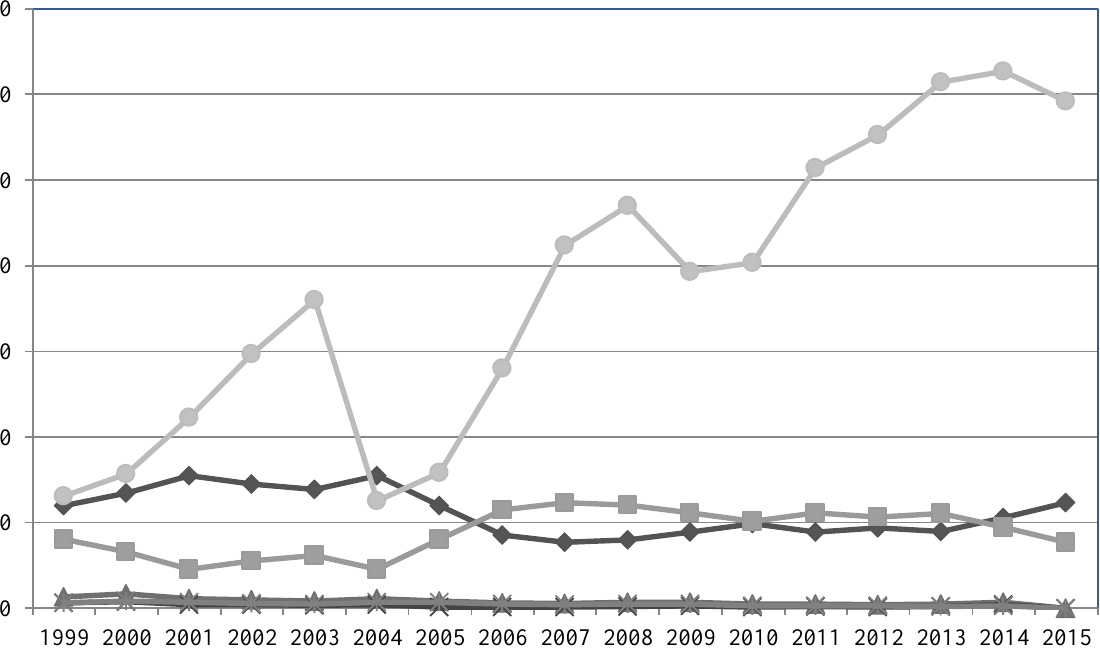
Fig. 2. Graphical view of trends in volume and structure of investments in capital assets to be allotted to agricultural development by sources of funding for 1999–2015 (compiled by authors to: